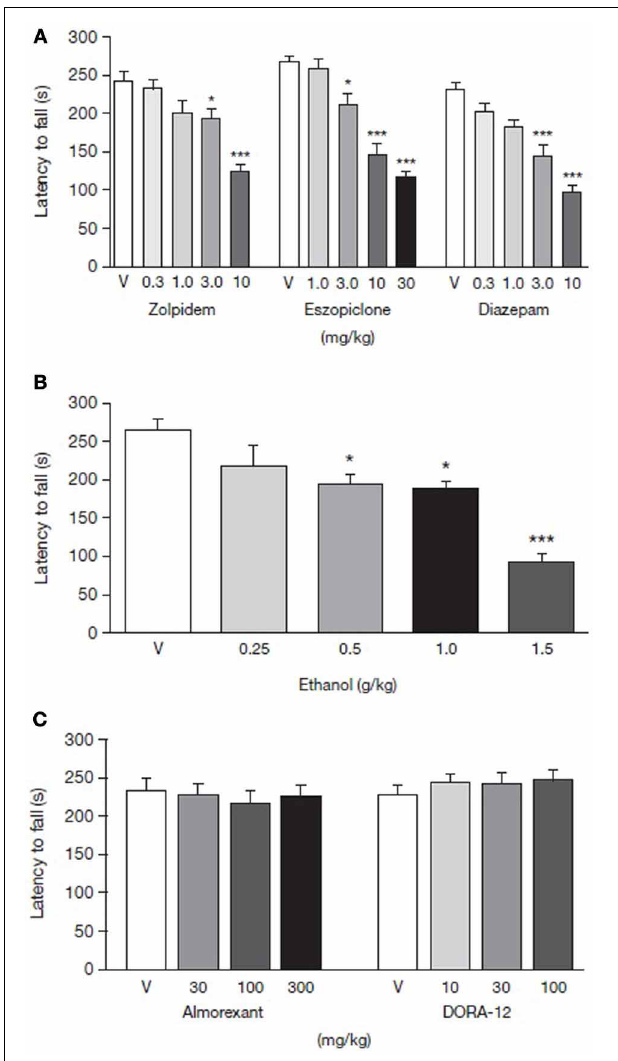
FIGURE 2 | Dose-response curve for latency to fall from rotarod for rats administered (A) GABA-A receptor modulators, (B) ethanol, and (C) orexin receptor antagonists. Comparison of GABA-A receptor modulators, ethanol and orexin receptor antagonists in terms of latency to fall using rotarod as a measure of motor performance. Paraoral acute administration of zolpidem, eszopiclone, diazepam, and IP administration of ethanol dose-dependently impairs rotarod performance. Paraoral doses of orexin receptor antagonists, almorexant and DORA-12, do not impair locomotor performance after acute administration. Data are shown as mean ± standard error of the mean. ∗ p < 0 . 05, ∗∗∗ p < 0 . 001 for the level of significance vs. the vehicle-treated group. ANOVA post-hoc Newman-Keuls multiple comparison tests ( n = 7–12). ANOVA, analysis of variance; PO, per oral; V, vehicle.